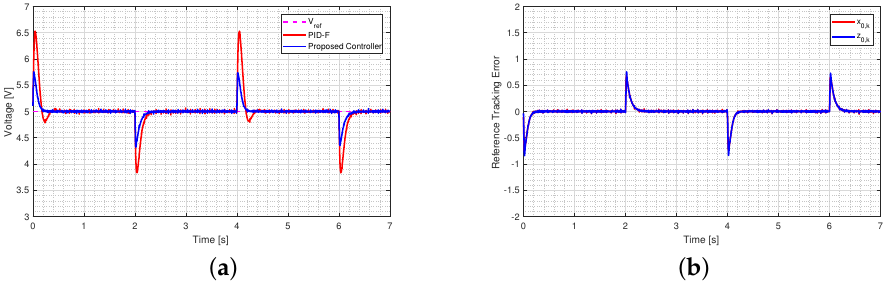
Figure 7. Load variation performance of the proposed controller and a saturated discrete − time PID with τ = 250 µ s. ( a ) Output voltage and reference; ( b ) reference tracking error and its